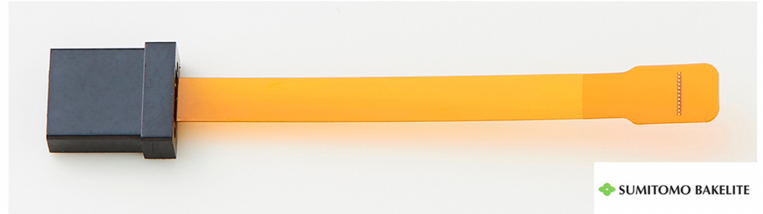
Figure 5. Photo-addressed waveguide termination of photo-addressed waveguides with PMT connector ( left side ) and out-of-plane coupling array ( right end ) Source: Sumitomo Bakelite.